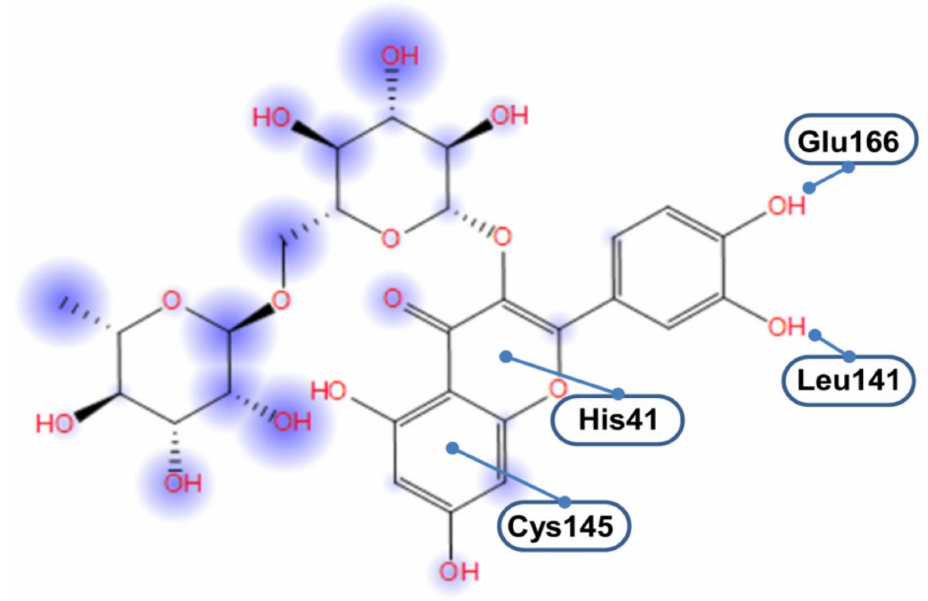
Figure 6. Schematic representation of the interactions of rutin within the active site of 3CLpro. Circular halos around rutin atoms are proportional to solvent